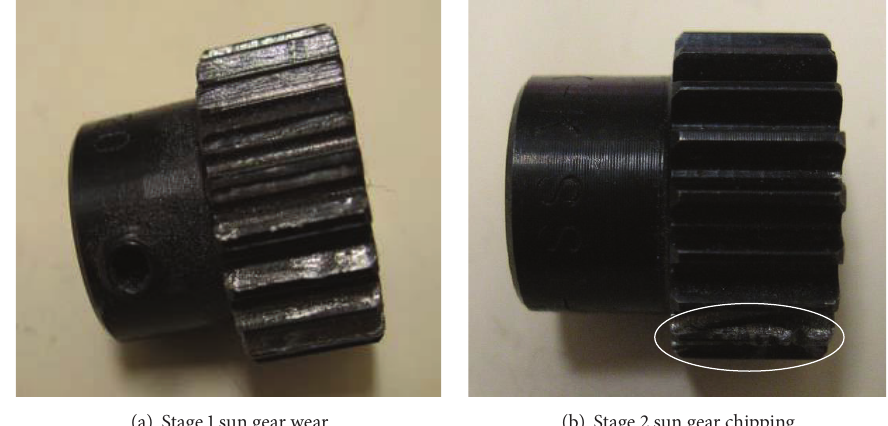
Figure 4: Sun gear damage.